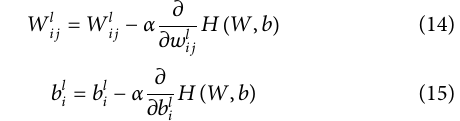
TABLE 4 Comparison of CT staging and pathological T staging results. Pathological staging CT